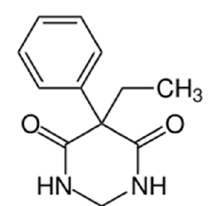
Figure 1. Chemical structure of primidone.